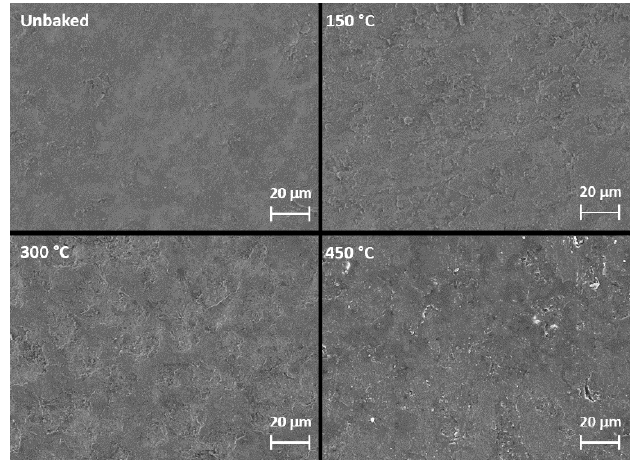
Figure 5. SEM images of the samples surface.